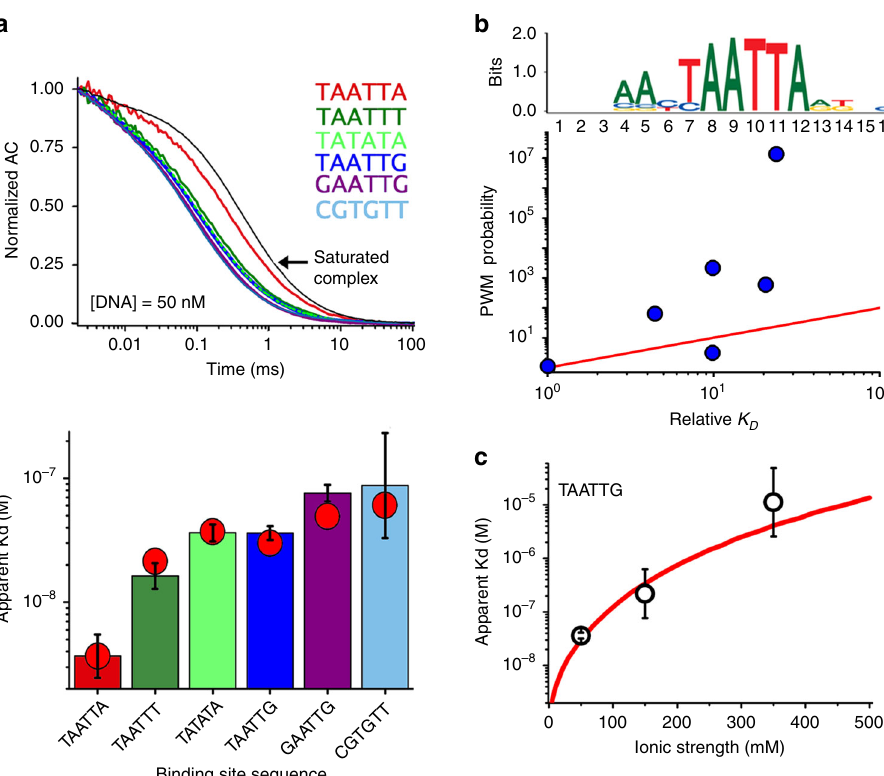
Fig. 2 Mapping the energetics of EngHD binding to DNA. a (top) Experimental FCS autocorrelation decays of EngHD in the presence of 50 nM of each of the six 75-bp DNA molecules based on the β 3 tubulin gene with variations in the SB site. The average diffusion time relative to diffusion of the saturated complex (black curve) re fl ects the fraction of bound molecules. (bottom) Dissociation constants for the six 75-bp DNAs determined experimentally by FCS from three independent experiments and calculated by the statistical mechanical model (red circles). b Experimental changes in binding af fi nity compared with the changes expected by pure consensus binding. The upper panel shows the consensus binding logo for engrailed obtained from bacterial one-hybrid high throughput assays. The lower panel shows the correlation between the experimental changes in binding af fi nity, K D (variant) · K D (speci fi c) − 1 , in the abscissa; and the inversed relative probability of binding calculated from the position weight matrix, p PWM (speci fi c) · p PWM (variant) − 1 , in the ordinate. c Ionic strength dependence of EngHD binding to the 75-bp DNA molecule bearing the natural TAATTG high af fi nity site (dark blue in a ). Experimental data are shown as black open circles and the statistical mechanical model calculation is shown as a red curve. Bars delimit the 95% con fi dence interval, see Supplementary Table 2. Source data are provided as a Source Data fi le.